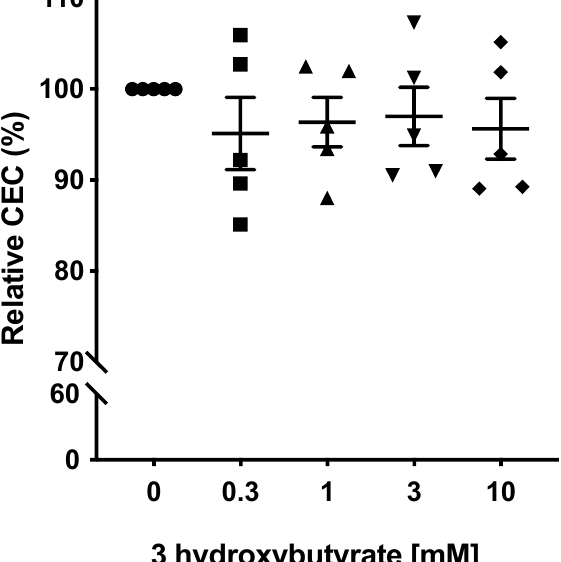
Figure 3. Effect of the supplementation of the Apo B-depleted plasma with ( ± )-sodium 3-hydorxybutyrate at different concentrations in CEC. Data were not statistically different ( p = 0.84; Mann – Whitney test).